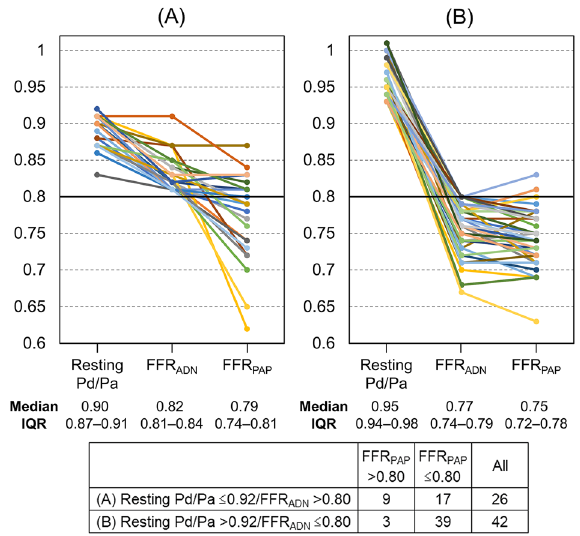
Figure 4. Individual resting Pd/Pa, FFR ADN , and FFR PAP values in the low Pd/Pa − high FFR ADN and high Pd/ Pa − low FFR ADN groups. ( A ) Low Pd/Pa − high FFR ADN group (resting Pd/Pa > 0.92 and FFR ADN ≤ 0.80). ( B ) High Pd/Pa − low FFR ADN group (resting Pd/Pa ≤ 0.92 and FFR ADN > 0.80). FFR ADN fractional flow reserve value associated with adenosine, FFR PAP fractional flow reserve value associated with papaverine, IQR interquartile range, Pd/Pa distal-to-aortic pressure